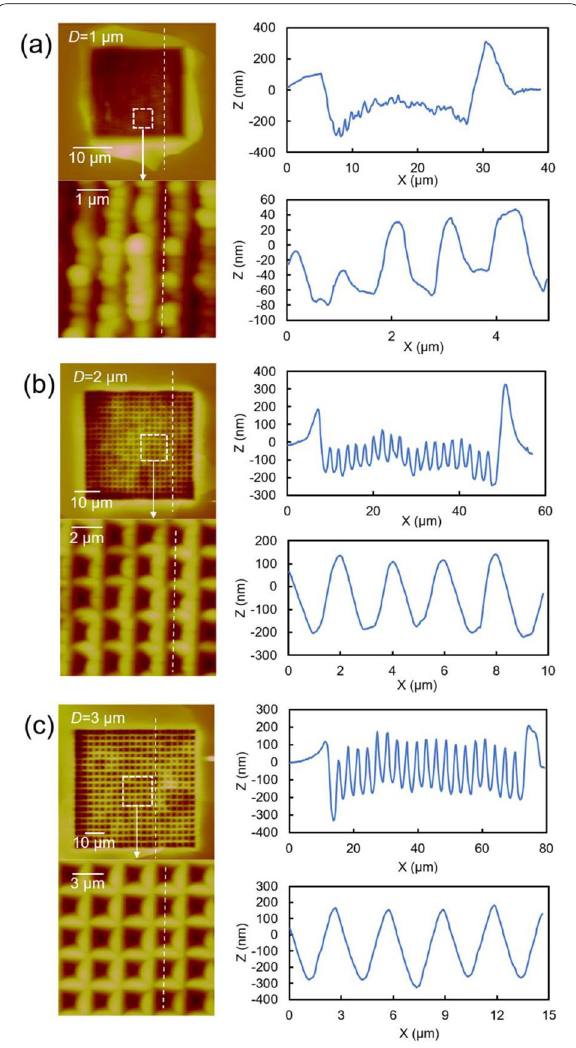
Figure 22 AFM images and the corresponding cross-sections of the experimental results for the 20 20 indentation arrays with the × rotation angle of 45° and the spacings of a 1 μm, b 2 μm and c 3